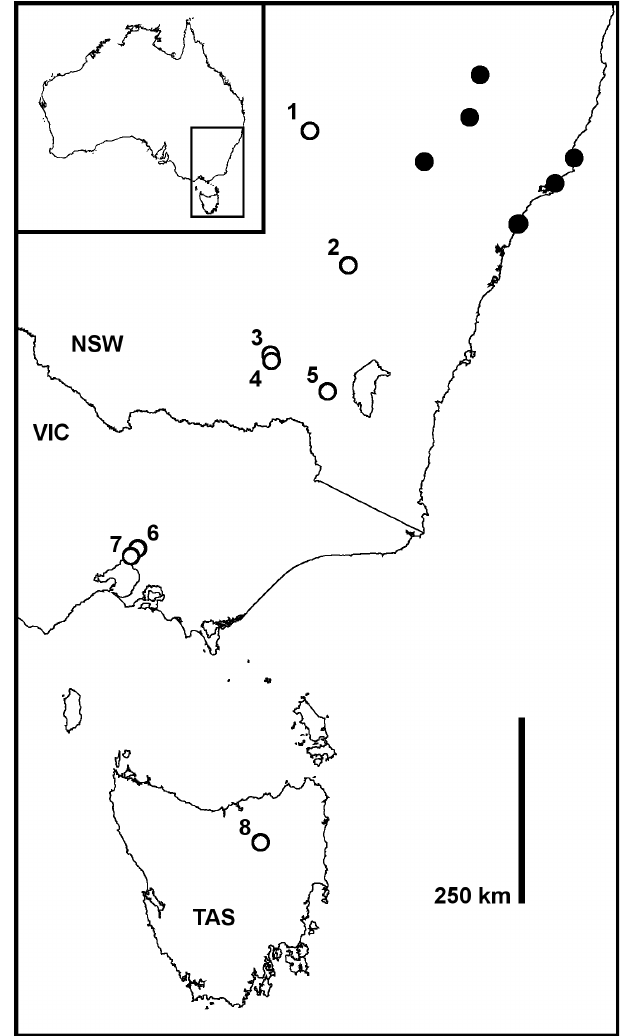
Figure 5. Known localities for Taxidiotisoma portabile sp. n. as of 30 March 2015 (filled and open circles). The eight numbered localities are discussed in the text. Geographic projection; inset shows location of main